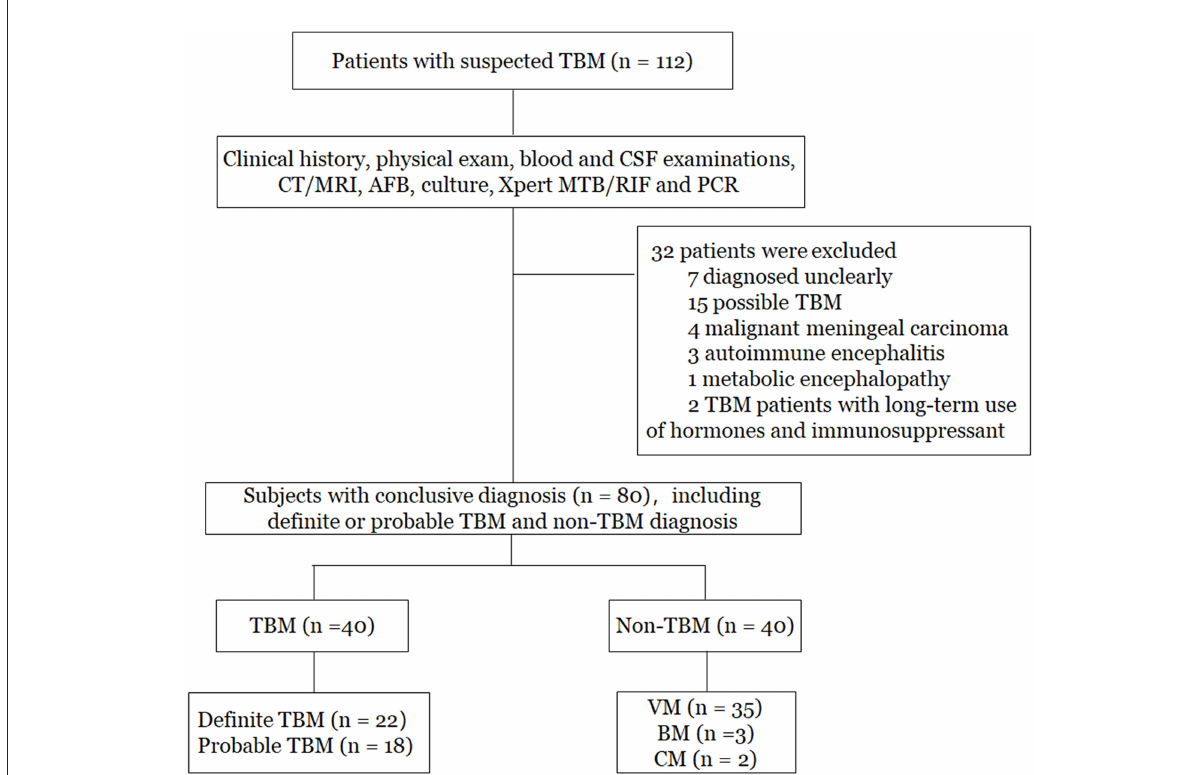
FIGURE1 Flowchart of the study participants. TBM, tuberculous meningitis; VM, viral meningitis; BM, bacterial meningitis; CM, cryptococcal meningitis; CT, computed tomography; MRI, magnetic resonance imaging; PCR, polymerase chain reaction.